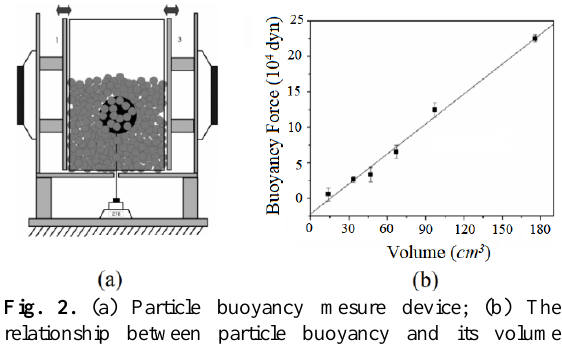
Fig. 2. (a) Particle buoyancy mesure device; (b) The relationship between particle buoyancy and its volume （ Huerta, 2005 ）